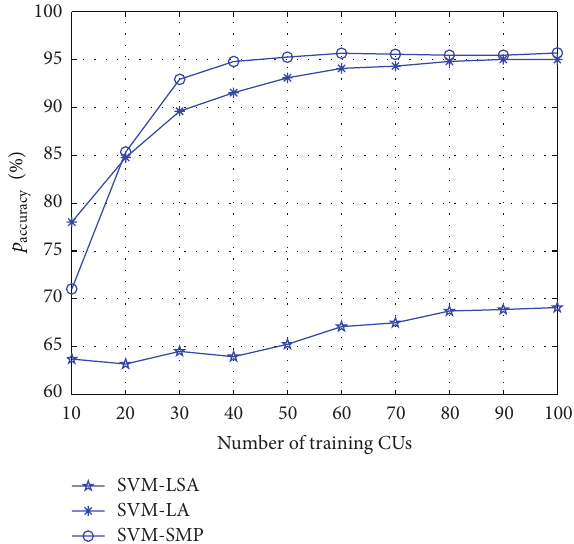
Figure 5: Miss prediction rate 𝑝